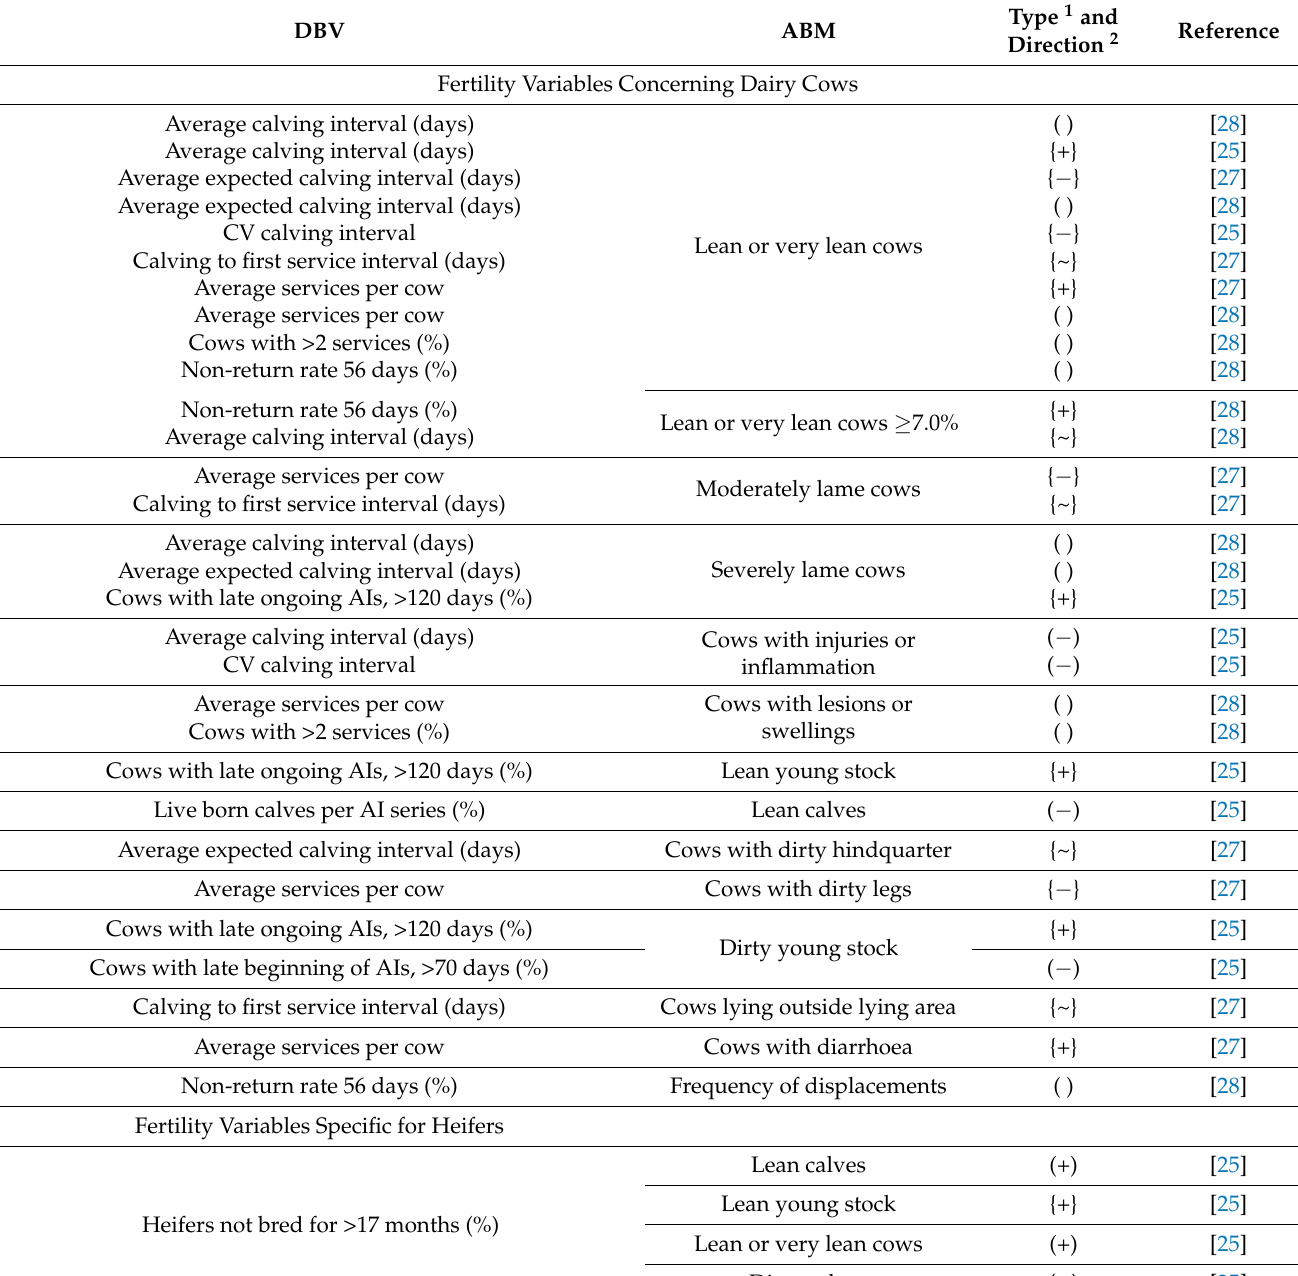
Type 1 and Reference Direction 2